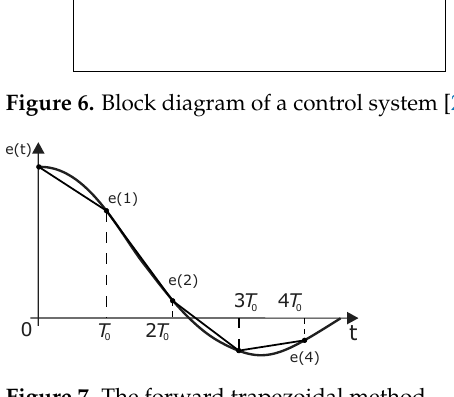
Figure 7. The forward trapezoidal method.